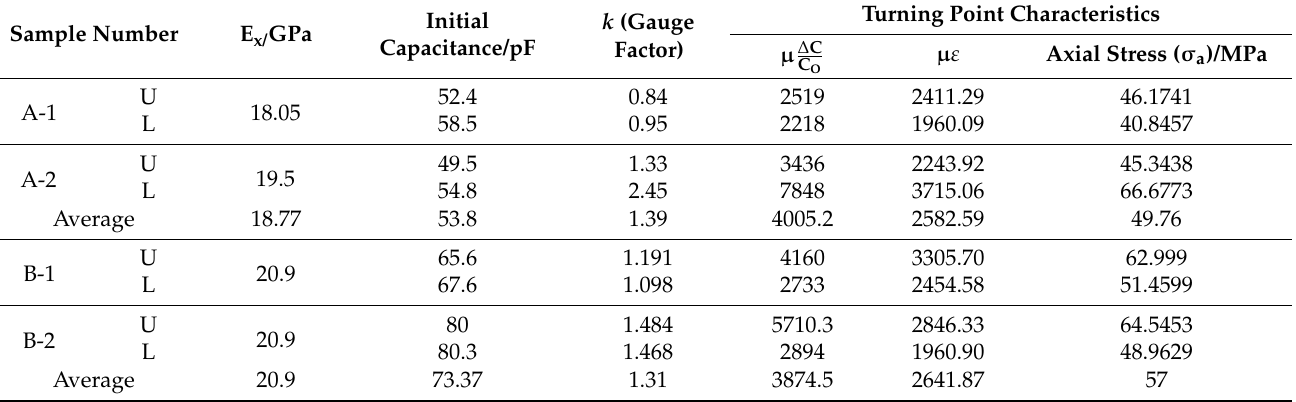
Table 3. Electrical and mechanical results obtained from the tensile tests for type-A and -B specimen